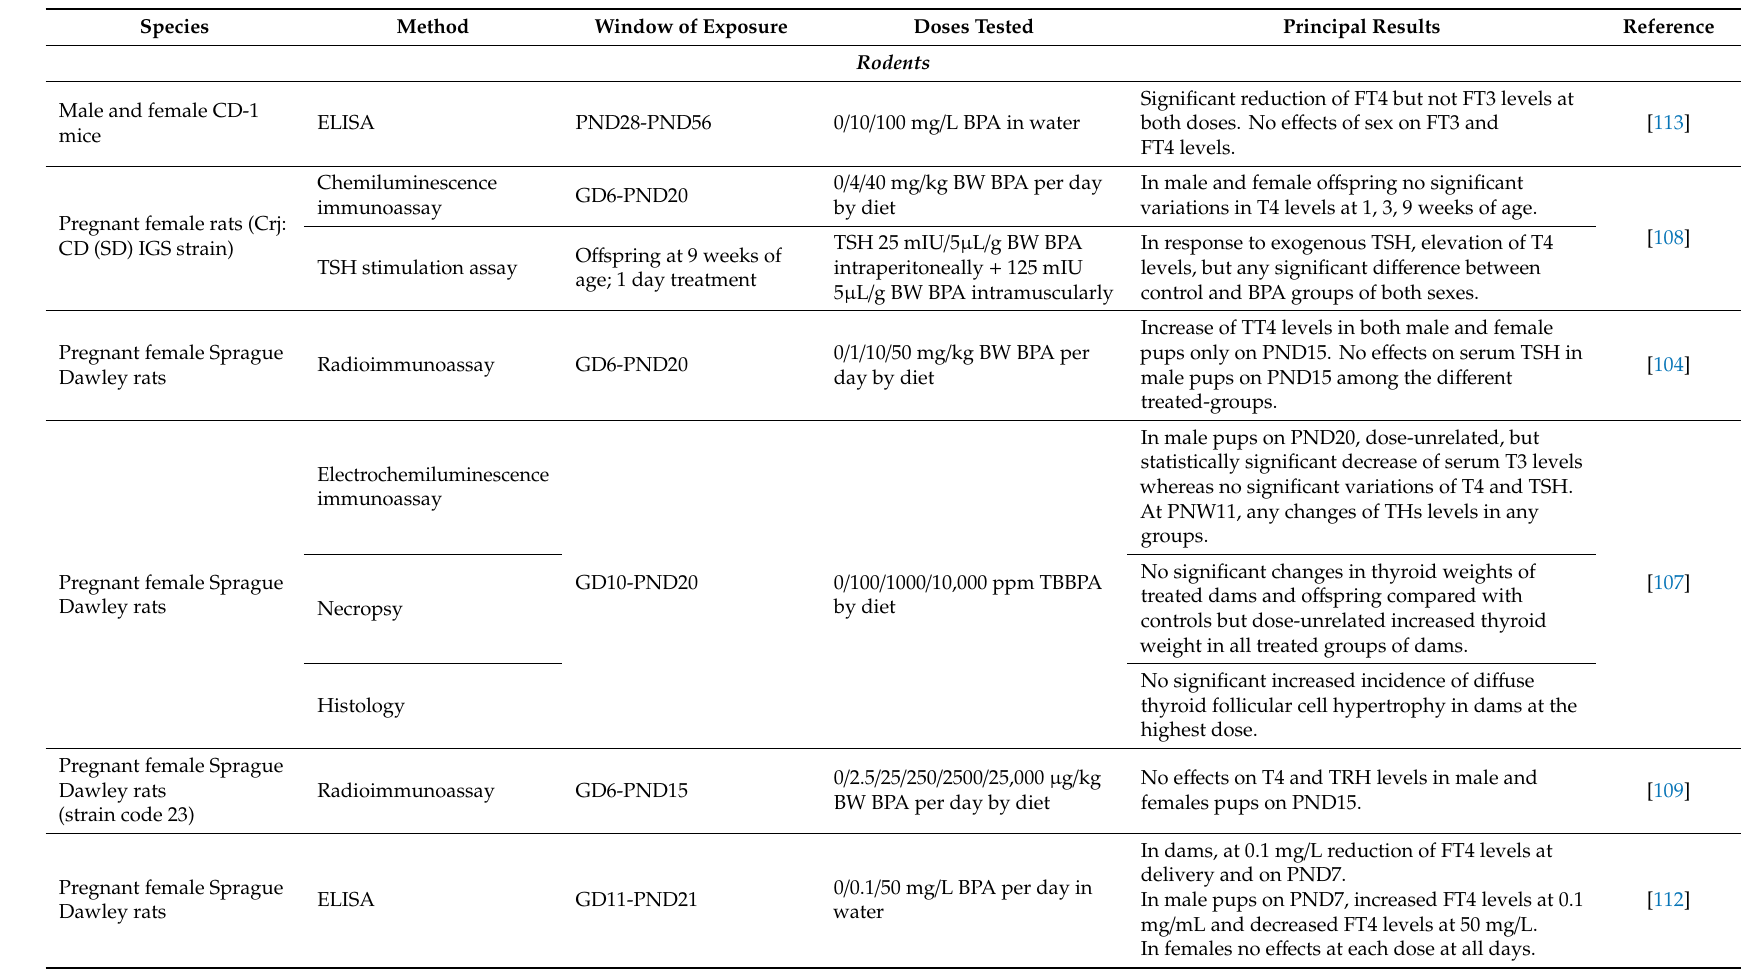
Table 3. Summary of in vivo studies analyzing e ff ects of exposure to bisphenols on thyroid